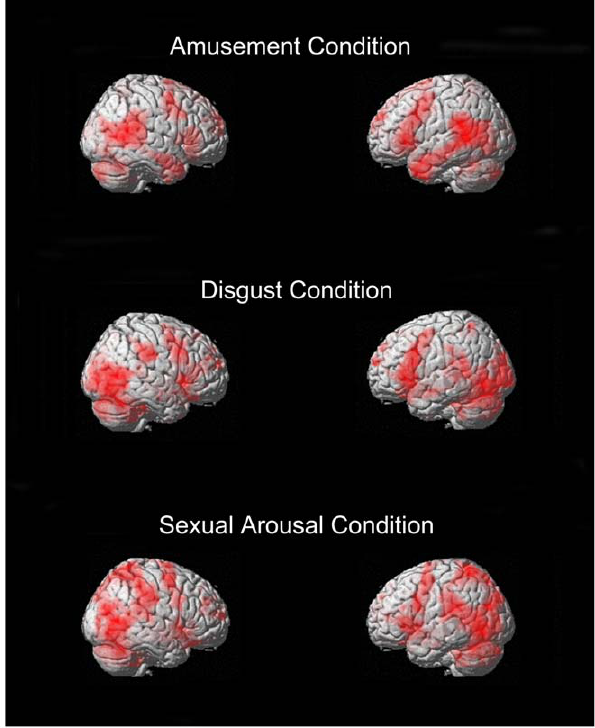
Figure 2. Three-dimensional rendered images of areas of supra-threshold areas of activation for the same contrasts as Figure 1. Here again, there similarities are obvious between contrasts. All contrasts clearly show involvement of the frontal operculum, dorsolateral prefrontal cortex, premotor and motor cortices, temporo- occipital regions, and cerebellum.